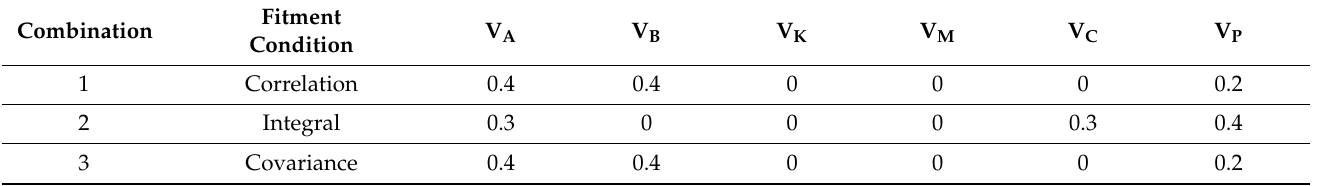
Table 3. Optimized dye solutions from solution UV-Vis data (reference Figure 7, quadrants I and II).